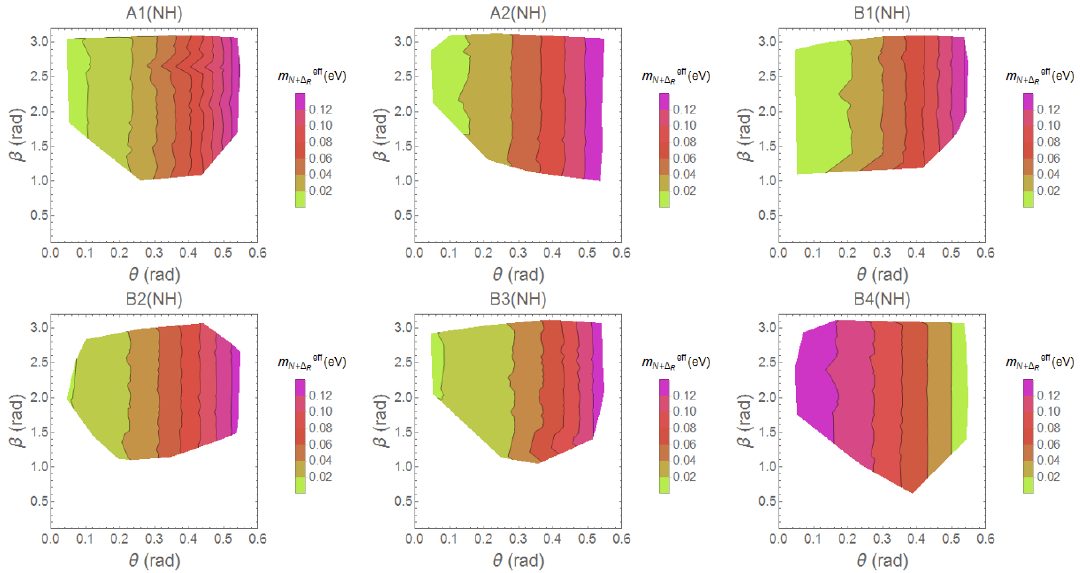
JHEP02(2019)129 Figure 4 . New physics contribution to e(cid:11)ective mass governing NDBD for di(cid:11)erent classes of two zero textures for NH shown as a function of two parameter (cid:18) and (cid:12) . The contour represents the e(cid:11)ective Majorana mass where 0.061 eV is the KamLAND-Zen upper limit. Figure 5 . New physics contribution to e(cid:11)ective mass governing NDBD for di(cid:11)erent classes of two zero textures for IH shown as a function of two parameter (cid:18) and (cid:12) . The contour represents the e(cid:11)ective Majorana mass where 0.061 eV is the KamLAND-Zen upper limit. { 18